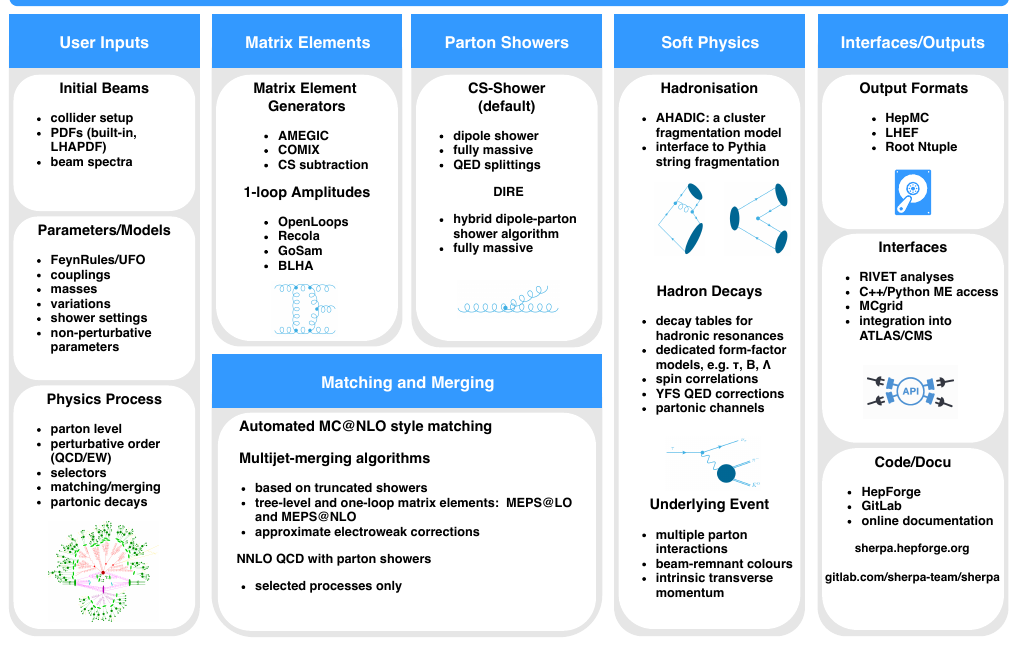
Figure 1: Overview of the S HERPA 2.2 event generator